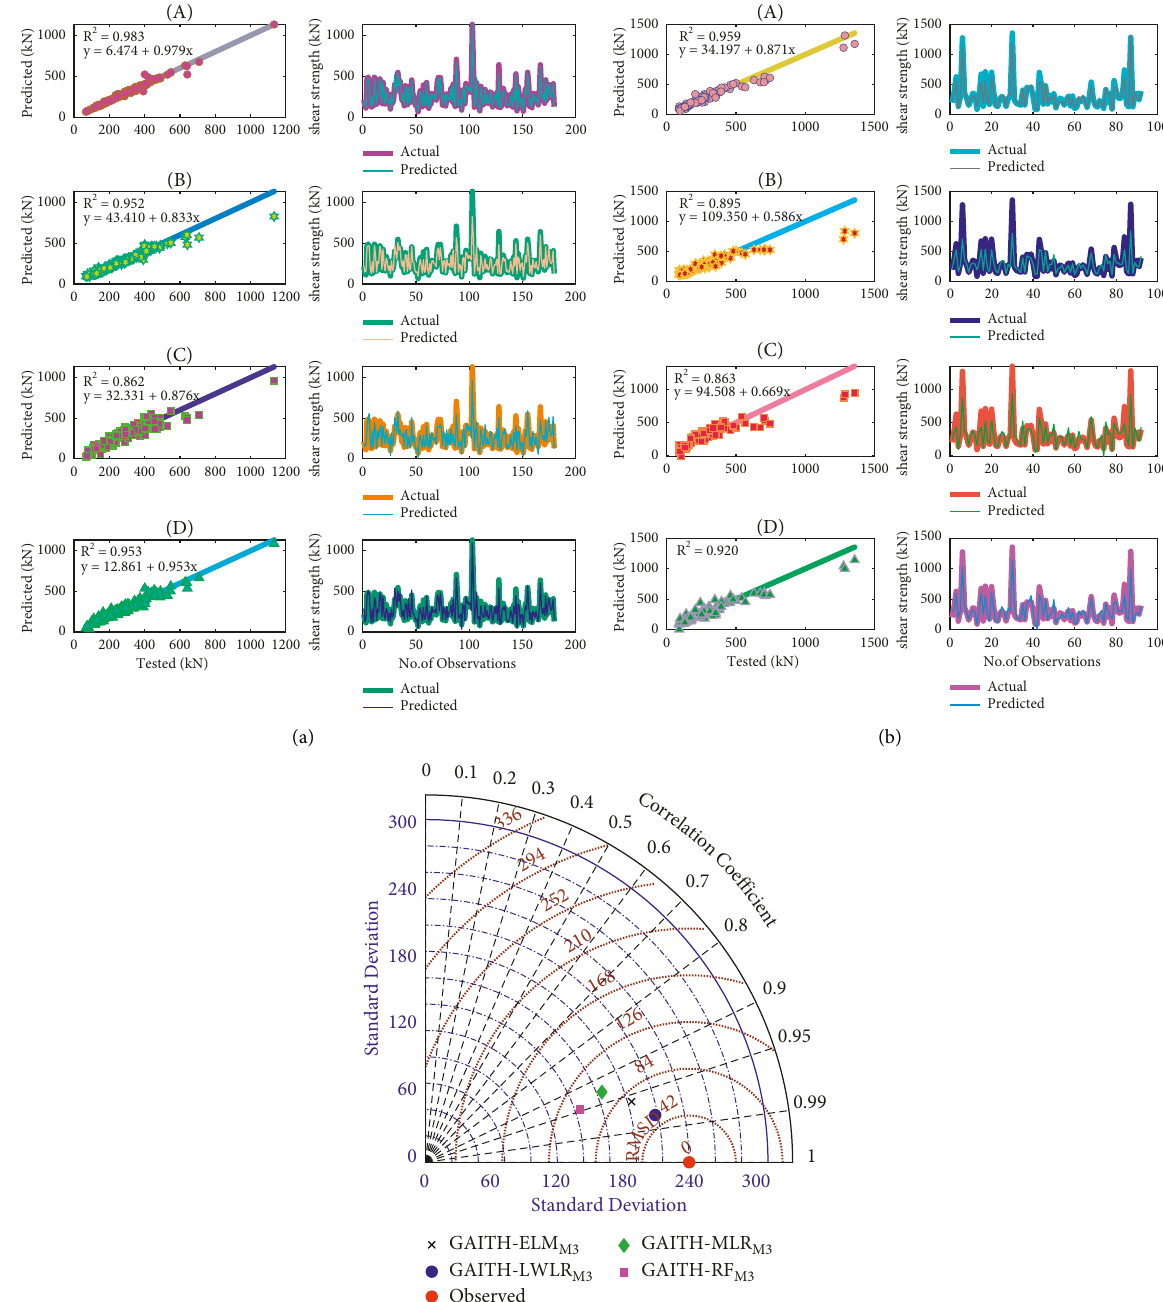
Figure 9: A comparison between the objectives of the models: (A)–(D) represent the GAITH − LWLR , and GAITH − ELM MLR M M 3 models, respectively. Figures (a) and (b) show scatter plots and line plots for the training and test data, 3 respectively, while figure (c) is a Taylor plot based on the test data. (a) Training data. (b) Testing data. (c) Taylor